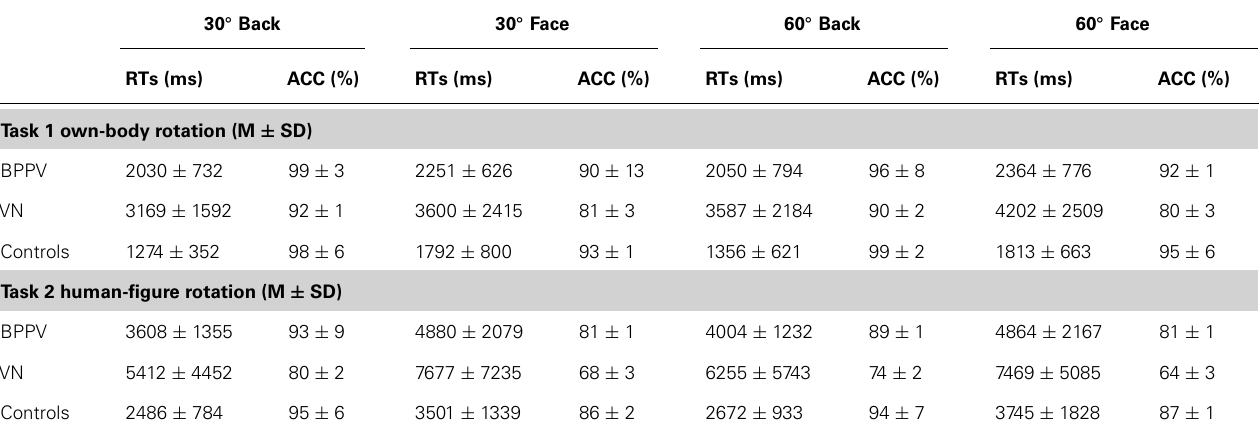
Task 2 human-figure rotation (M ±